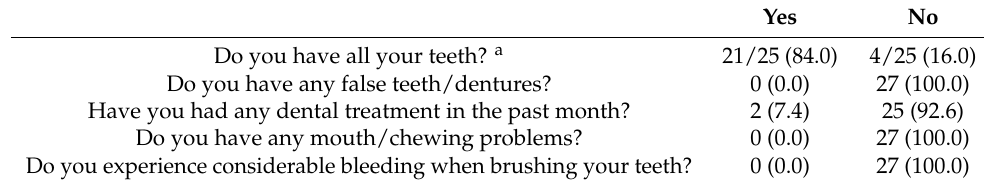
Table 2. Participant dentition.